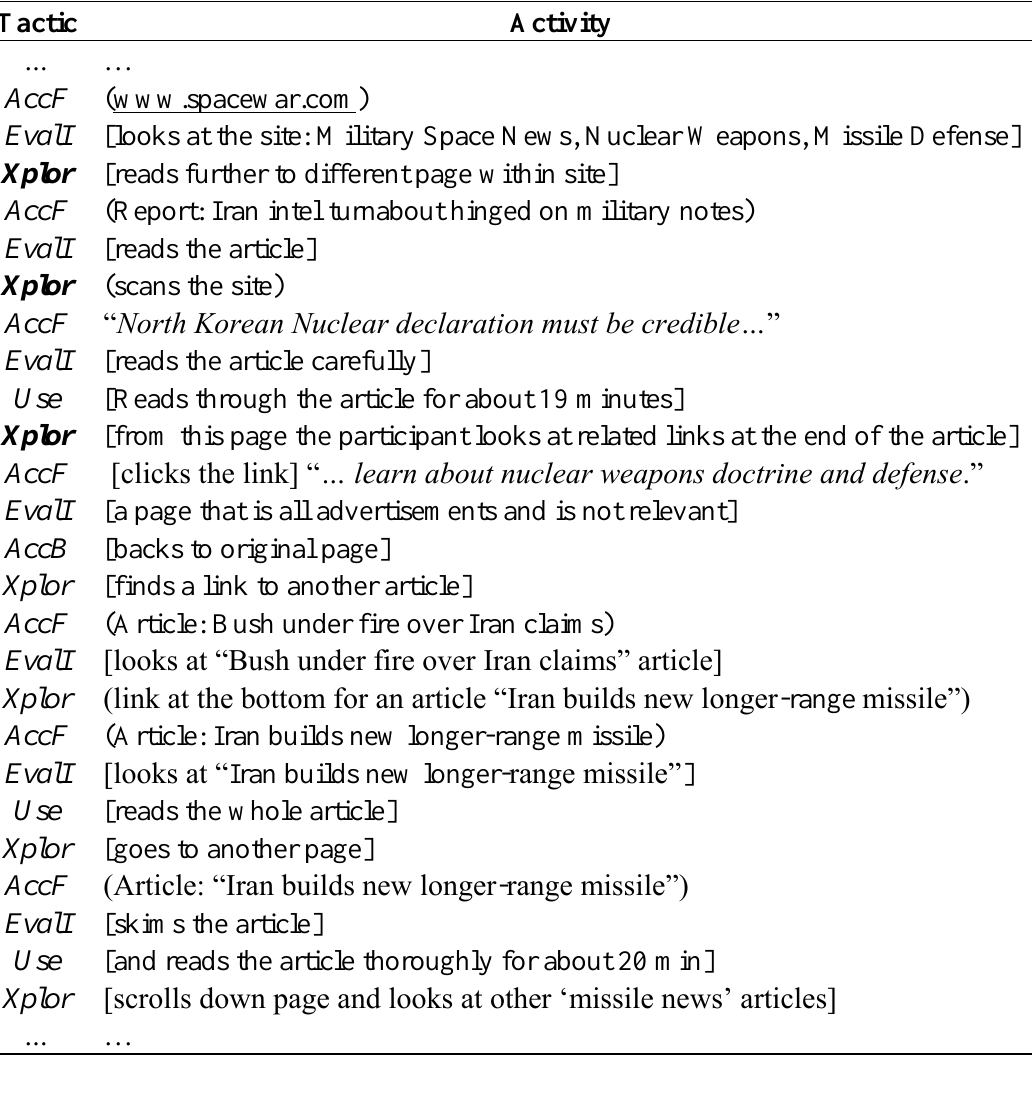
Table 6. Iterative exploration